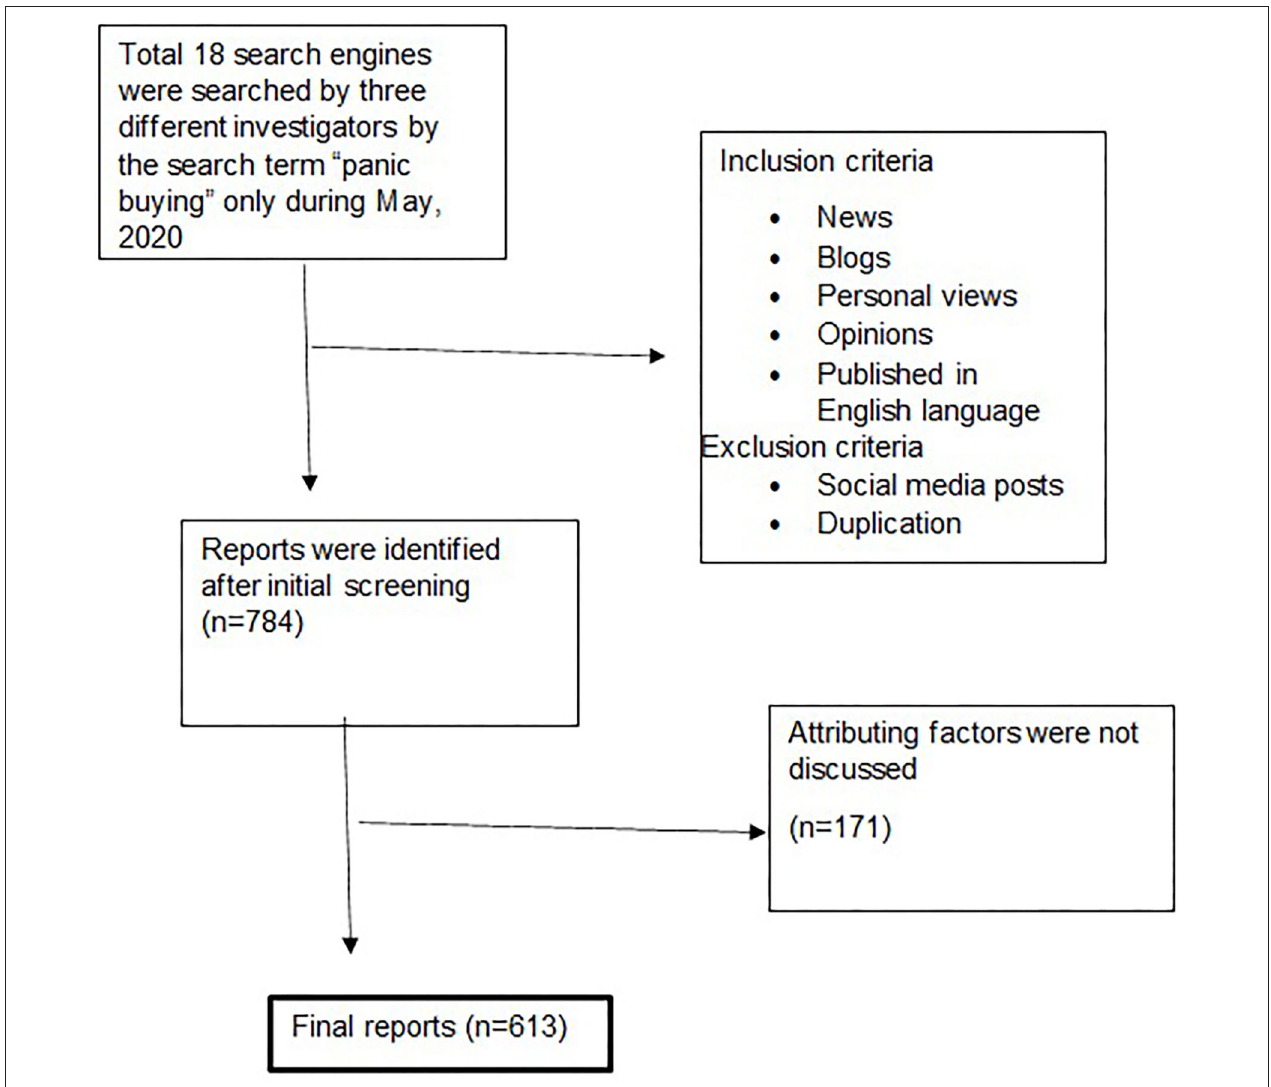
FIGURE 1 | Flow chart showing study sample selection.